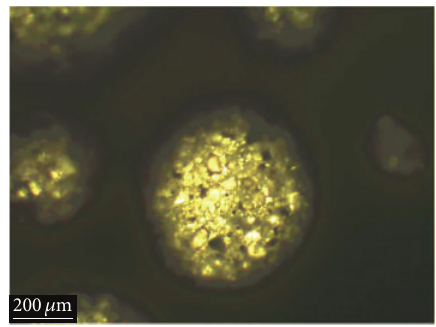
Figure 8: The fresh state of foam